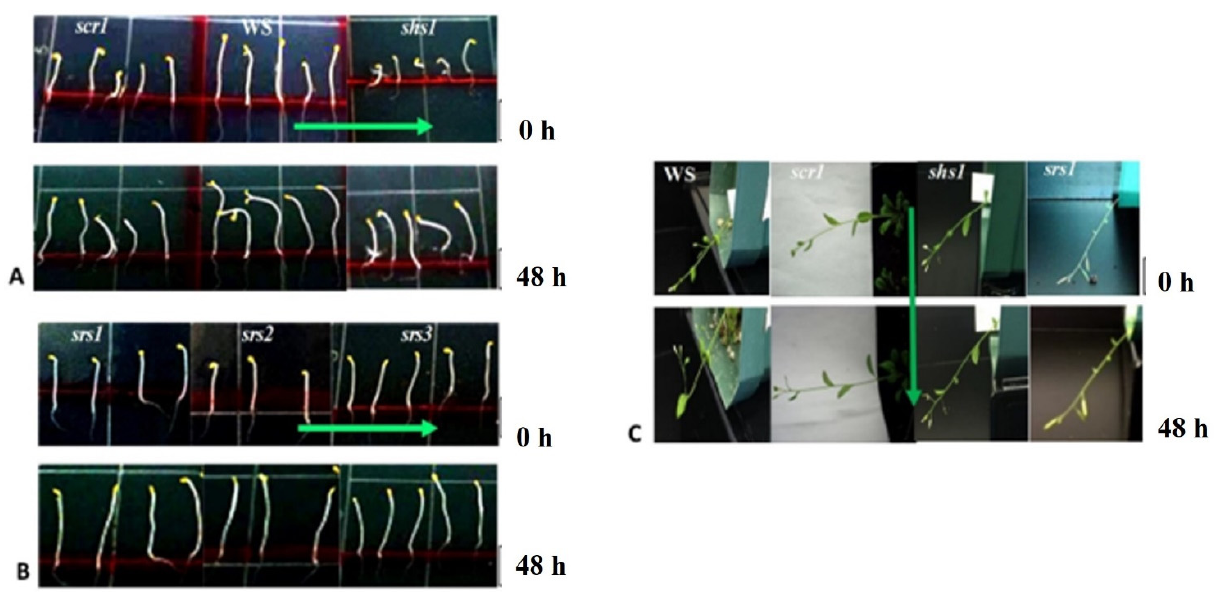
Figure 3. Hypocotyl and Inflorescence gravitropism in A. thaliana . ( A ) Hypocotyl gravitropic responses in the dark of the scr1 , WS and shs1 . The seedlings of scr1 , WS and shs1 ( scr hypocotyl gravitropic suppressor1) are shown at reorientation (0 h) and 48 h (48 h) after reorientation. Arrows indicate the direction of the gravity vector. ( B ) Hypocotyl gravitropic responses in the dark of srs1–3 . The seedlings of srs1–3 are shown at reorientation (0 h) and 48 h (48 h) after reorientation. Arrows indicate the direction of the gravity vector. ( C ) Inflorescence gravitropic response in the dark of the WS, scr1 , shs1 and srs1 ( scr root length suppressor1 ). Inflorescences of the WS, scr1 , shs1 and srs1 are shown at reorientation (0 h) and 24 h (24 h) after reorientation in the dark. Arrows indicate the direction of the gravity vector.